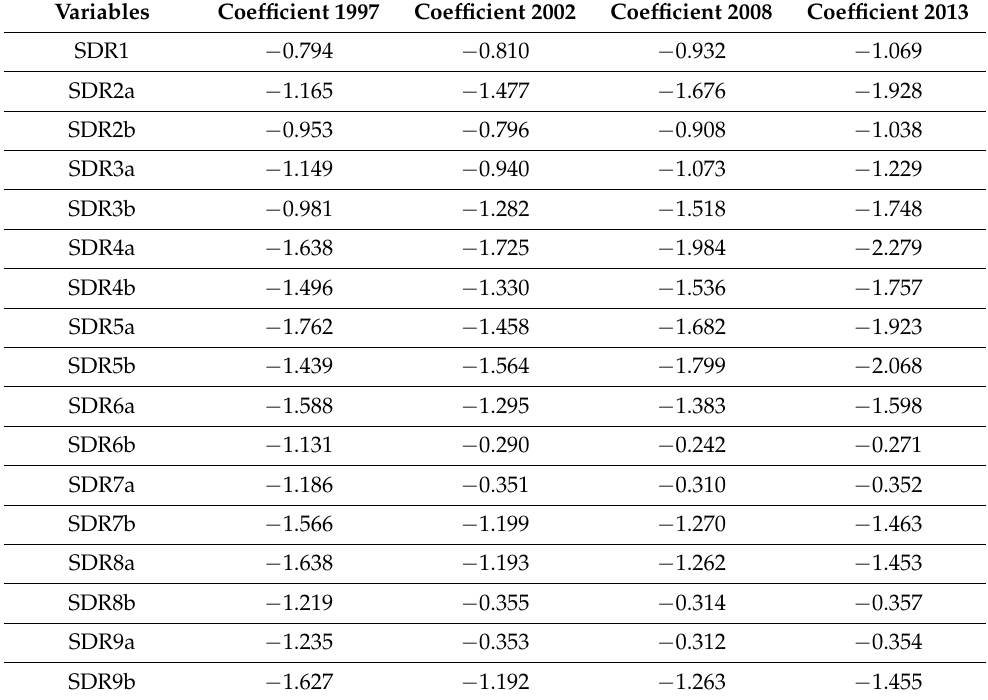
Table 5. Shadow prices for combined codes indicating land slope and